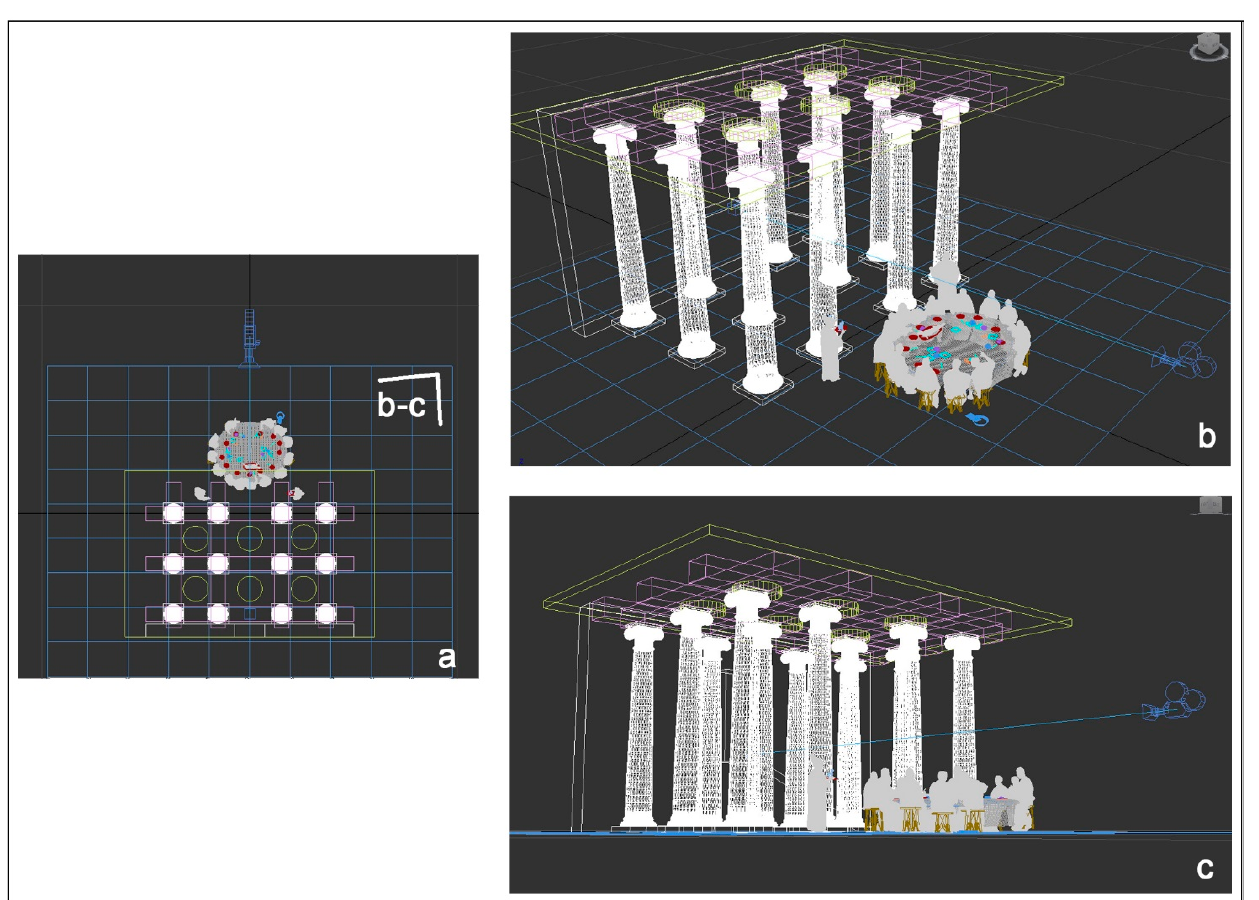
Figure 10. ( a ) Plan of the scene reconstructed from the perspective restitution; ( b ) top view of the scene; ( c ) bottom view of the scene.